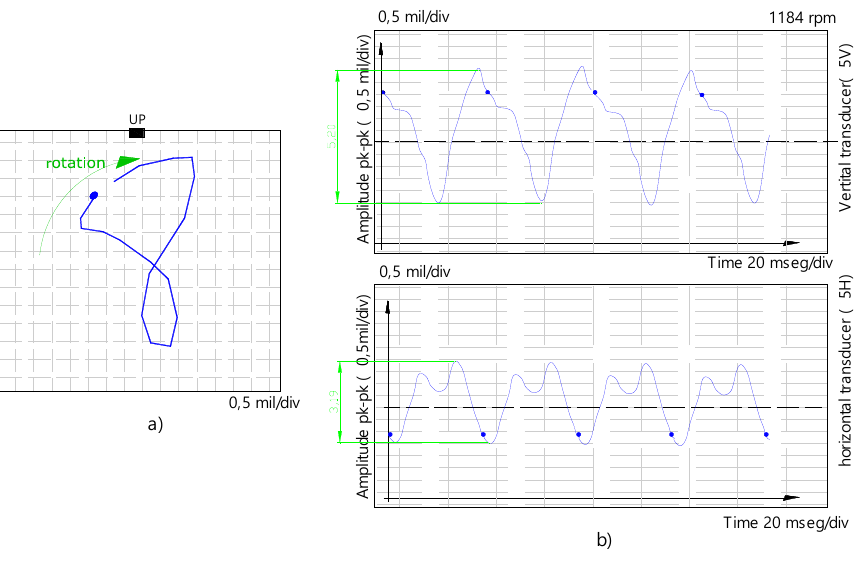
Figure 3. Orbit of the axis and amplitude/time of 5 V and 5 H transducers (81 N, 16